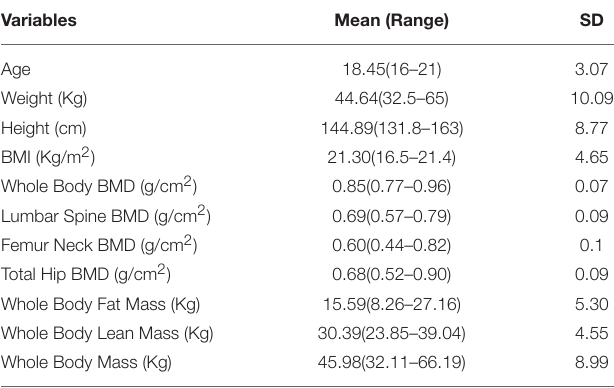
TABLE 1 | Basic clinical data of adolescent and young adult TS